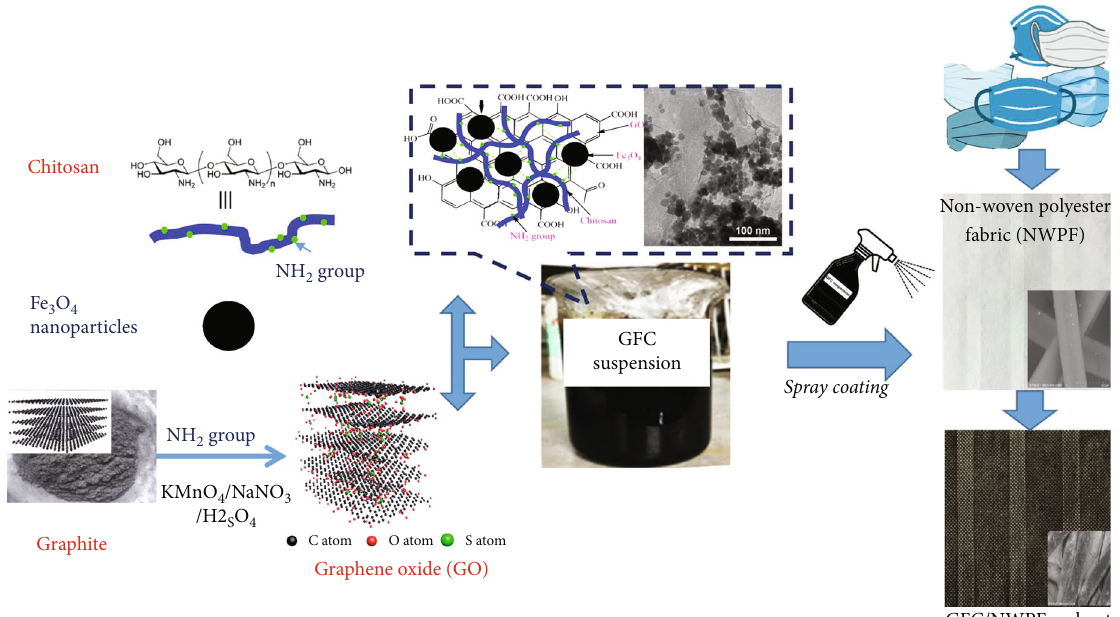
O /chitosan (GFC) coated onto nonwoven polyester 3 4